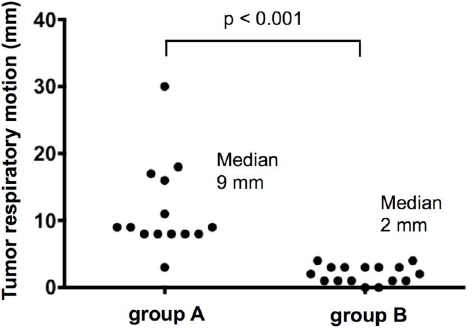
Figure 3. Three-dimensional tumor respiratory motion during treatment simulation evaluated with four-dimensional CT.